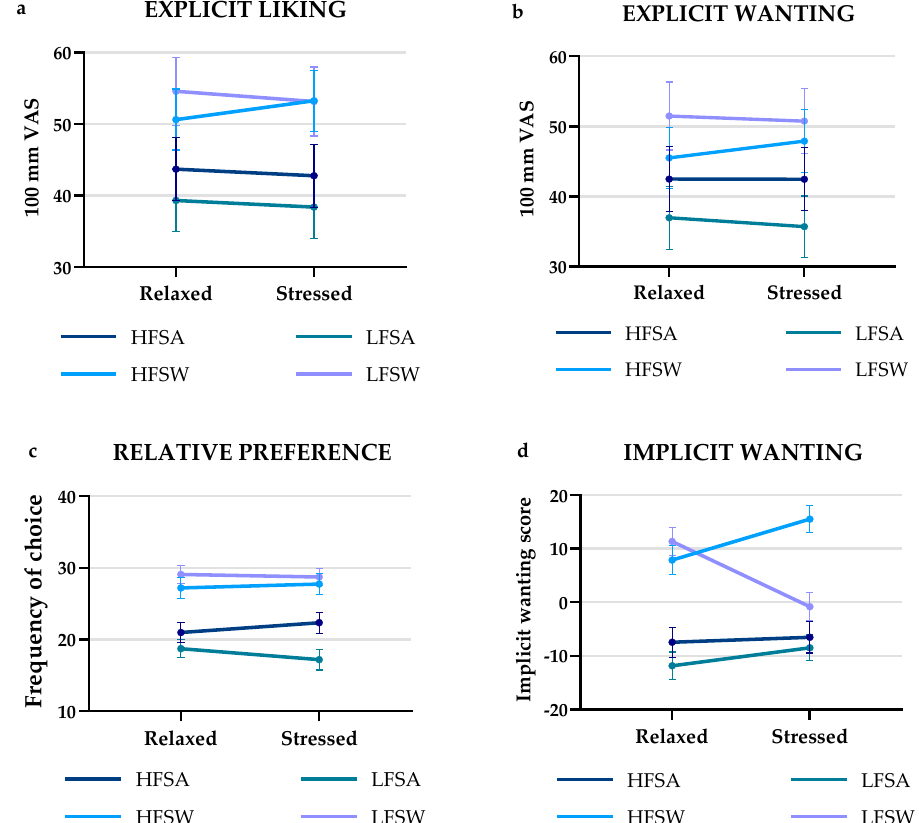
Figure 4. Interaction plots for ( a ) explicit liking (mean ± SEM), ( b ) explicit wanting (mean ± SEM), ( c ) relative preference (mean ± SEM) and ( d ) implicit wanting (mean ± SEM), for the four different food categories. HFSA: high-fat savory; HFSW: high-fat sweet; LFSA: low-fat savory; LFSW: low- fat sweet.